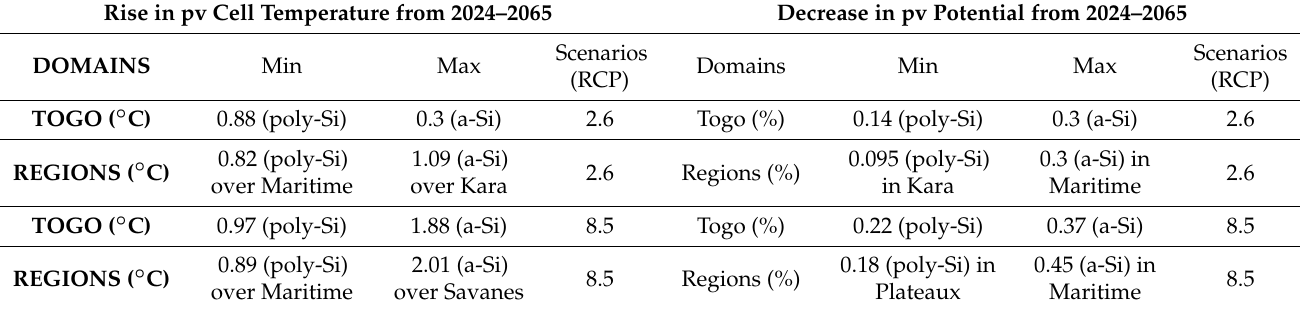
Table 5. Highlights of impact of CC on PVct and PVP over Togo and its Administrative